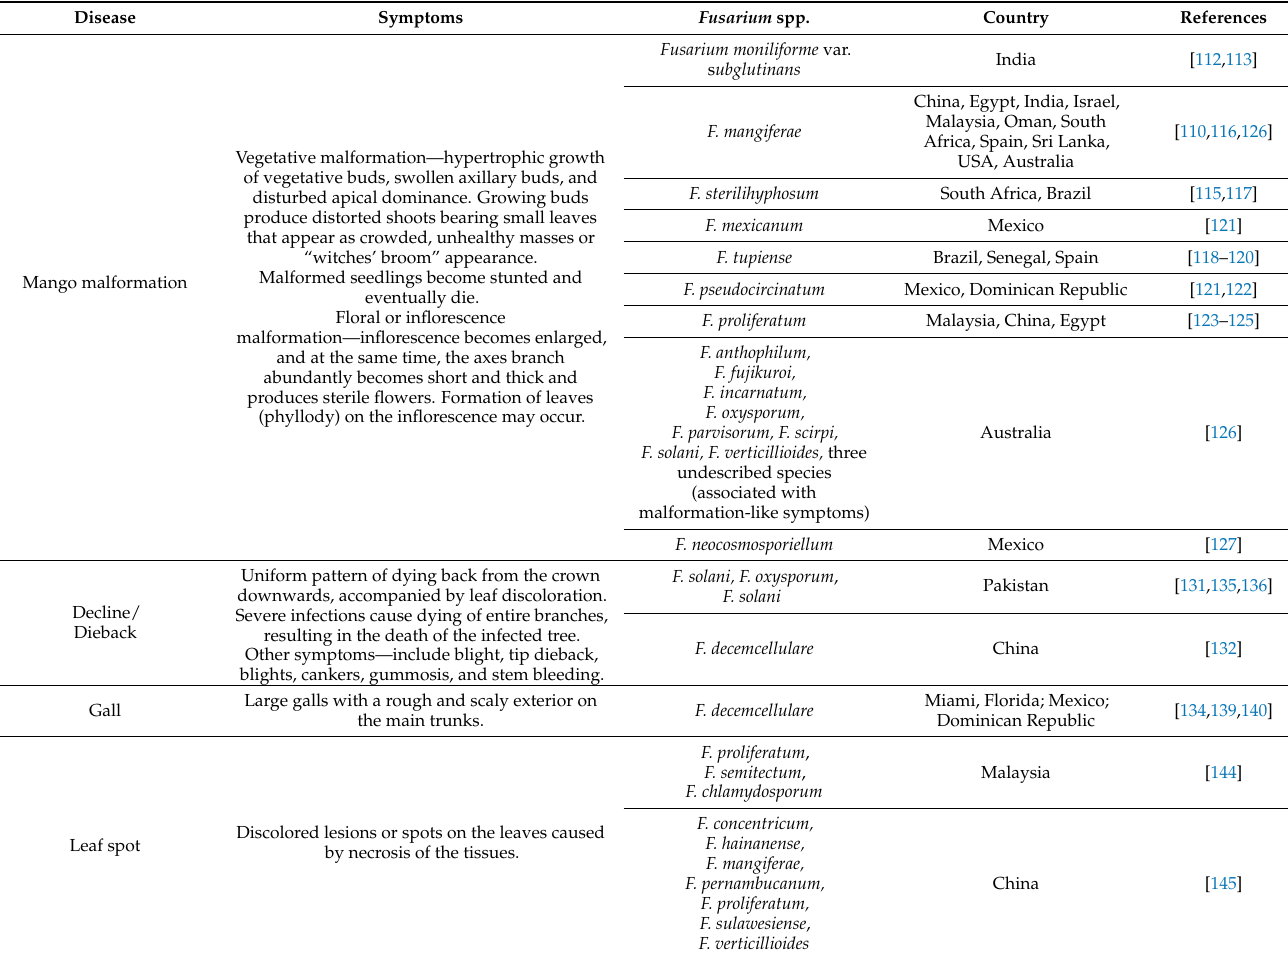
Table 3. Fusarium spp. associated with diseases of